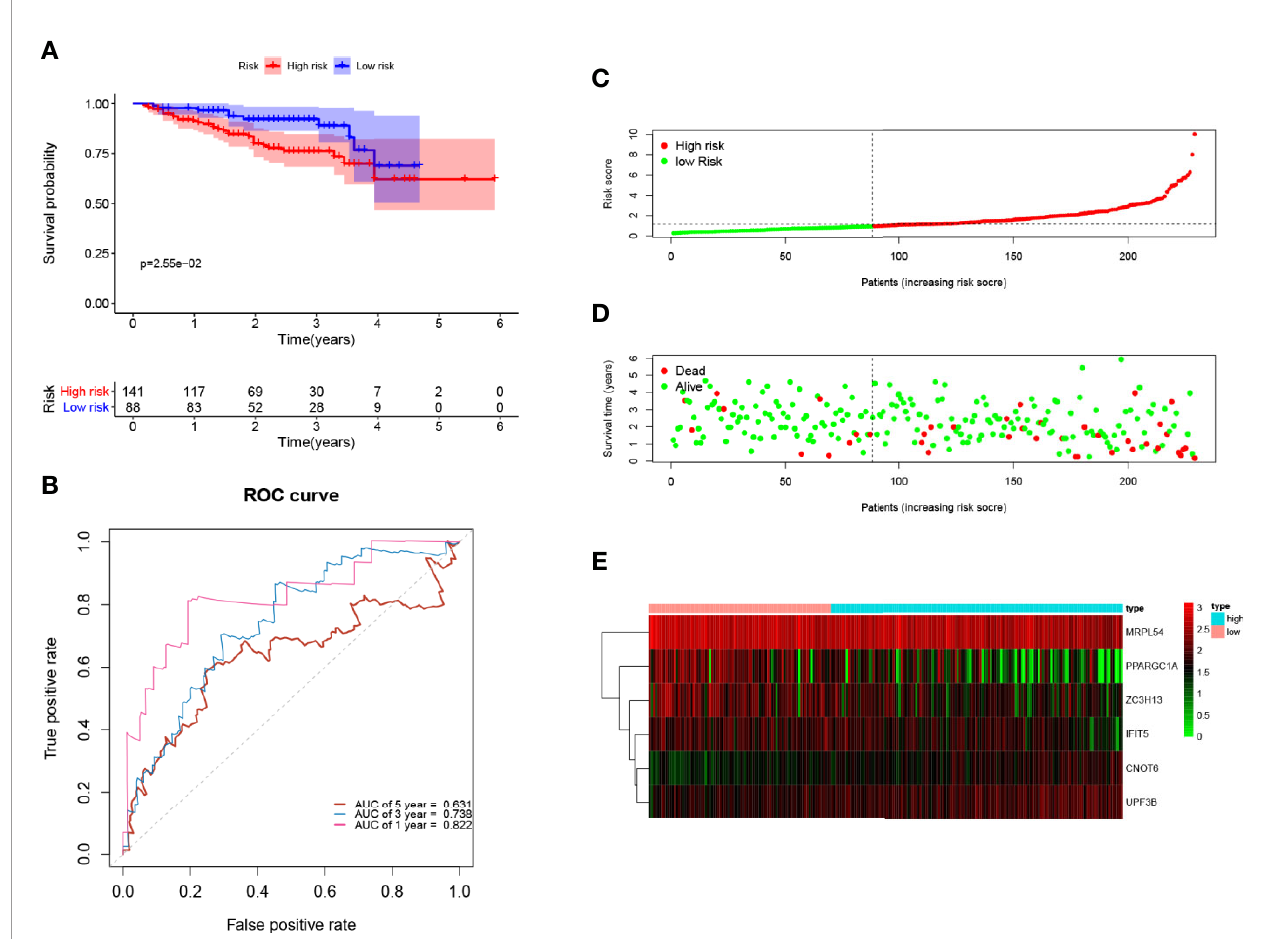
FIGURE 7 | Validation of the six-RBP gene prognostic signature in the ICGC cohort. (A) Kaplan-Meier survival curve of HCC patients in the high- and low-risk groups. (B) ROC curves for predicting 1-, 3-, 5-year overall survival. (C, E) Distribution of risk score, survival time, and heat map of six gene